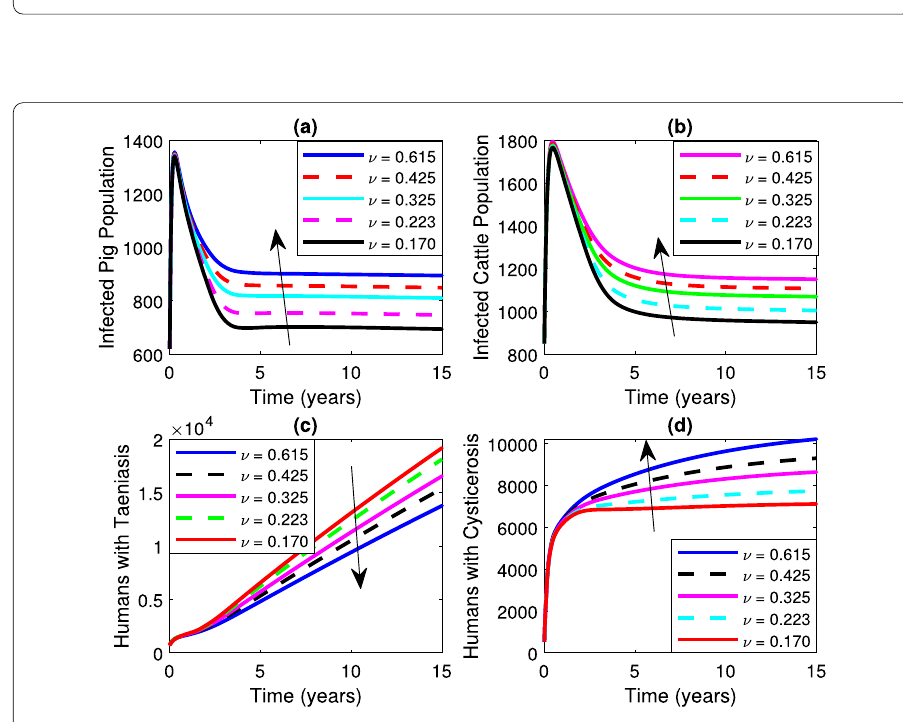
Figure 5 Impact of varying defecation rate on infected populations